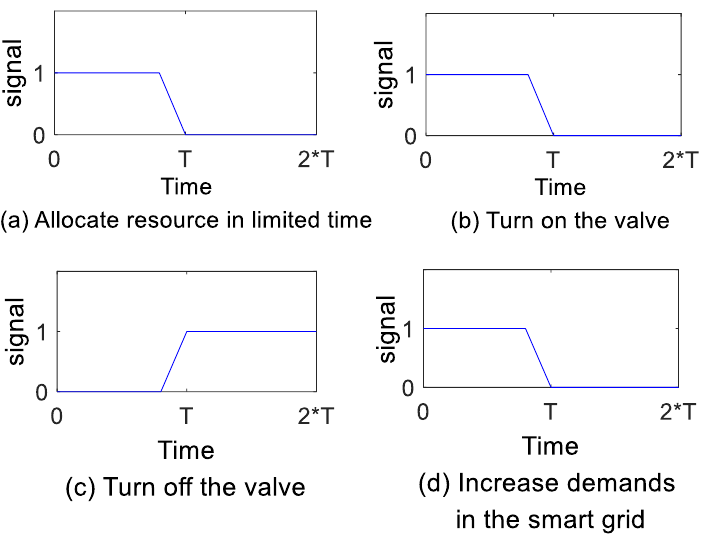
Figure 3. An example of heterogeneous data